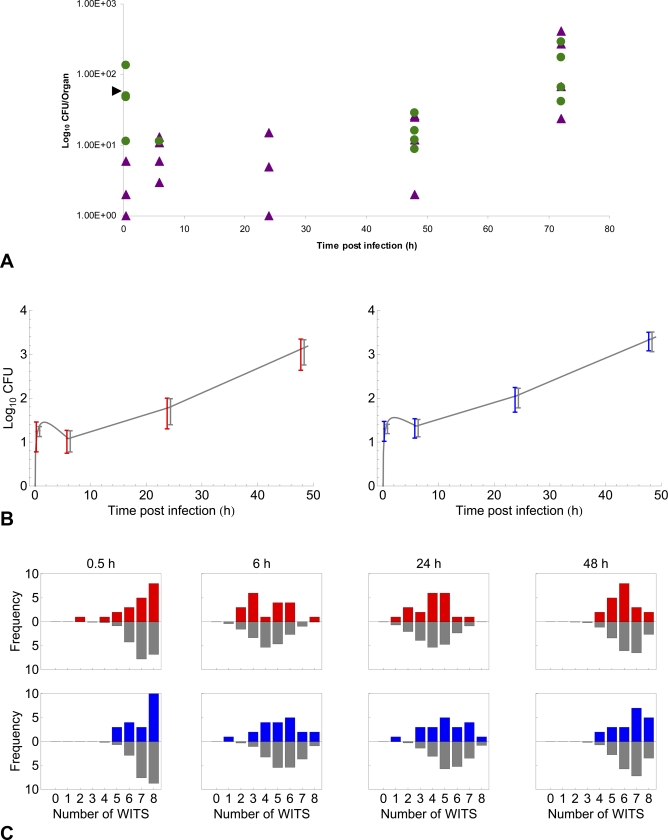
CFU and WITS Frequencies in the Organs of Infected Mice(A) Log10 CFU in “other organs” (purple triangle) and blood (green circle) at 0.5, 6, 24, 48 h (n = 5), and 72 h p.i. (n = 4); the arrow indicates inoculum size.(B) Log10 CFU in liver (red) and spleen (blue) (n = 20 per time point), results expressed as mean log10 viable count ± standard deviation. Lines (grey) indicate deterministic models; (grey) error bars indicate stochastic simulations (described in Protocol S1) expressed as mean ± standard deviation.(C) Frequency of WITS recovered from liver (red) and spleen (blue) compared to distributions of WITS as predicted from 1,000 stochastic simulations (grey).